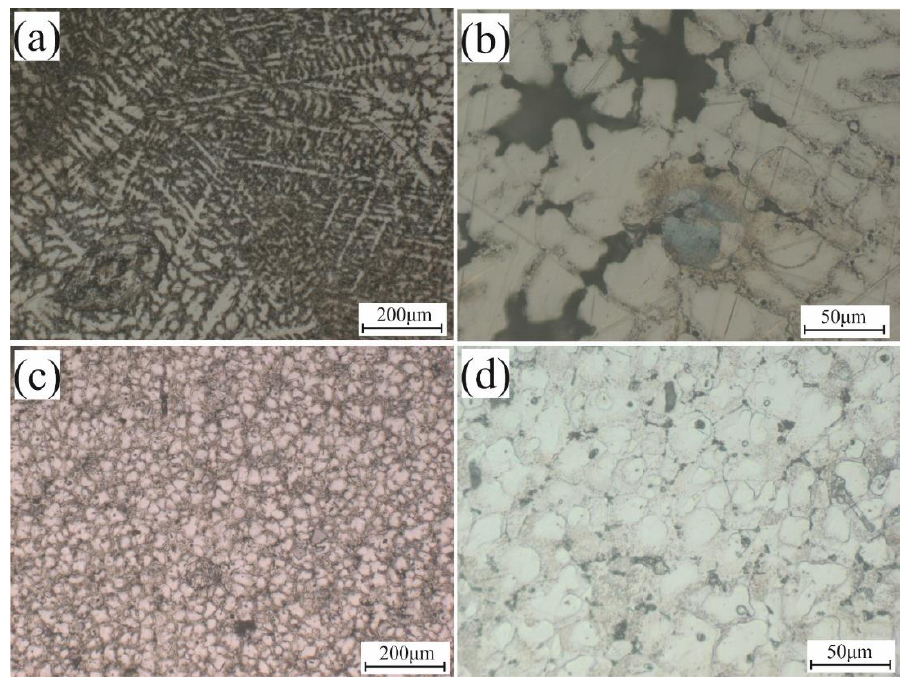
Figure 10. Microstructure after intergranular corrosion of the investigated alloys: ( a ) as-cast Al-2.5% Mg; ( b ) as cast Al-2.5% Mg after 24 h corrosion; ( c ) modified Al-2.5% Mg/Ti-B; and ( d ) the modified Al-2.5% Mg/Ti-B after corrosion.